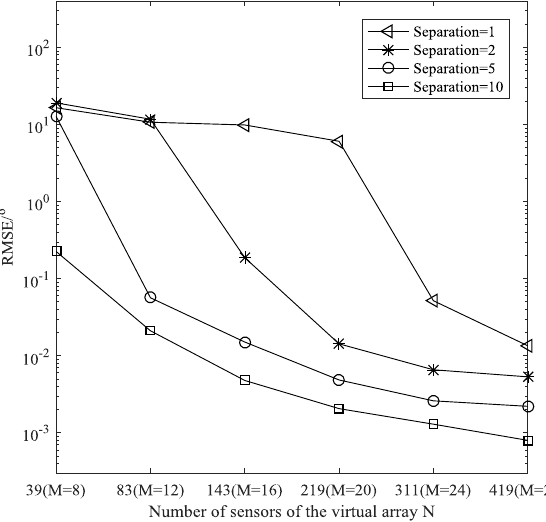
Figure 6. Estimation performance with different angular separation.